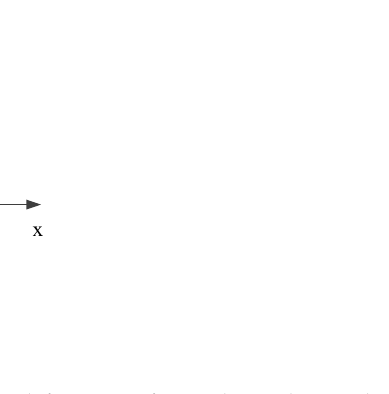
Figure 10. Schematic diagram of the deformation force relationship on the forming plane. The deformation force in the 𝑥𝑦 direction is periodic. During the forming process, each contour layer can be considered as a cycle with two peaks. The two peaks have essentially the same size and opposite directions. The radial deformation force on the modified forming plane is defined as the average of the absolute value of the peak value, while the axial deformation force is defined as the average value of the z-direction force at any ten points on the contour layer, as shown in Figures 11 and 12.